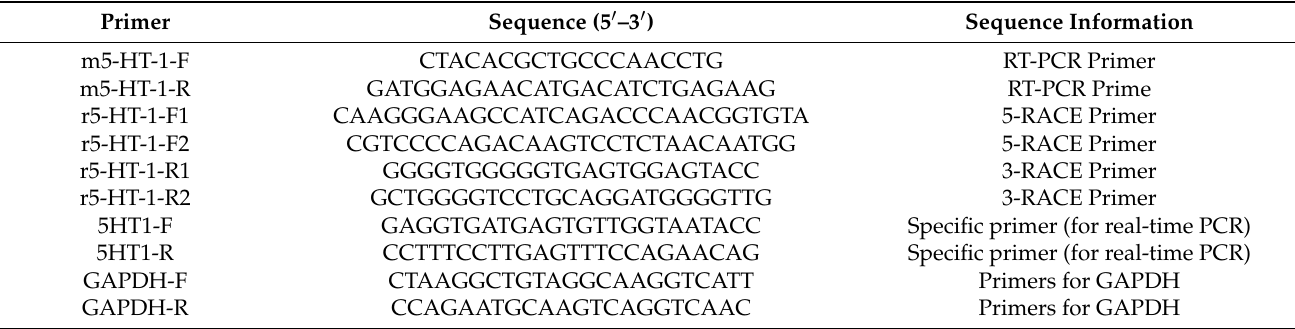
Table 1. Oligonucleotide primers used in the